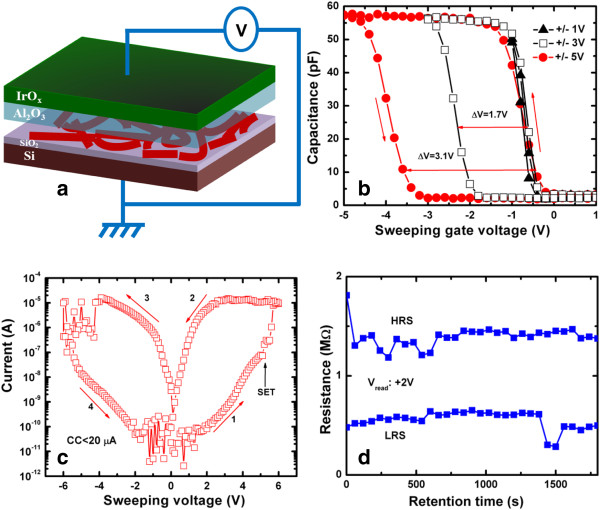
Schematic diagram, charge-trapping phenomena, and typical I-V hysteresis and retention characteristics. (a) Schematic diagram of the IrOx/Al2O3/Ge NWs/SiO2/p-Si MOS structure. (b) Charge-trapping phenomena observed by C-V measurements, proving the core-shell Ge/GeOx nanowires to contain defects. (c) Typical I-V hysteresis characteristics of the resistive switching memory device with a MOS structure. A low CC of <20 μA is needed to operate this RRAM device. (d) Retention characteristics of the device.